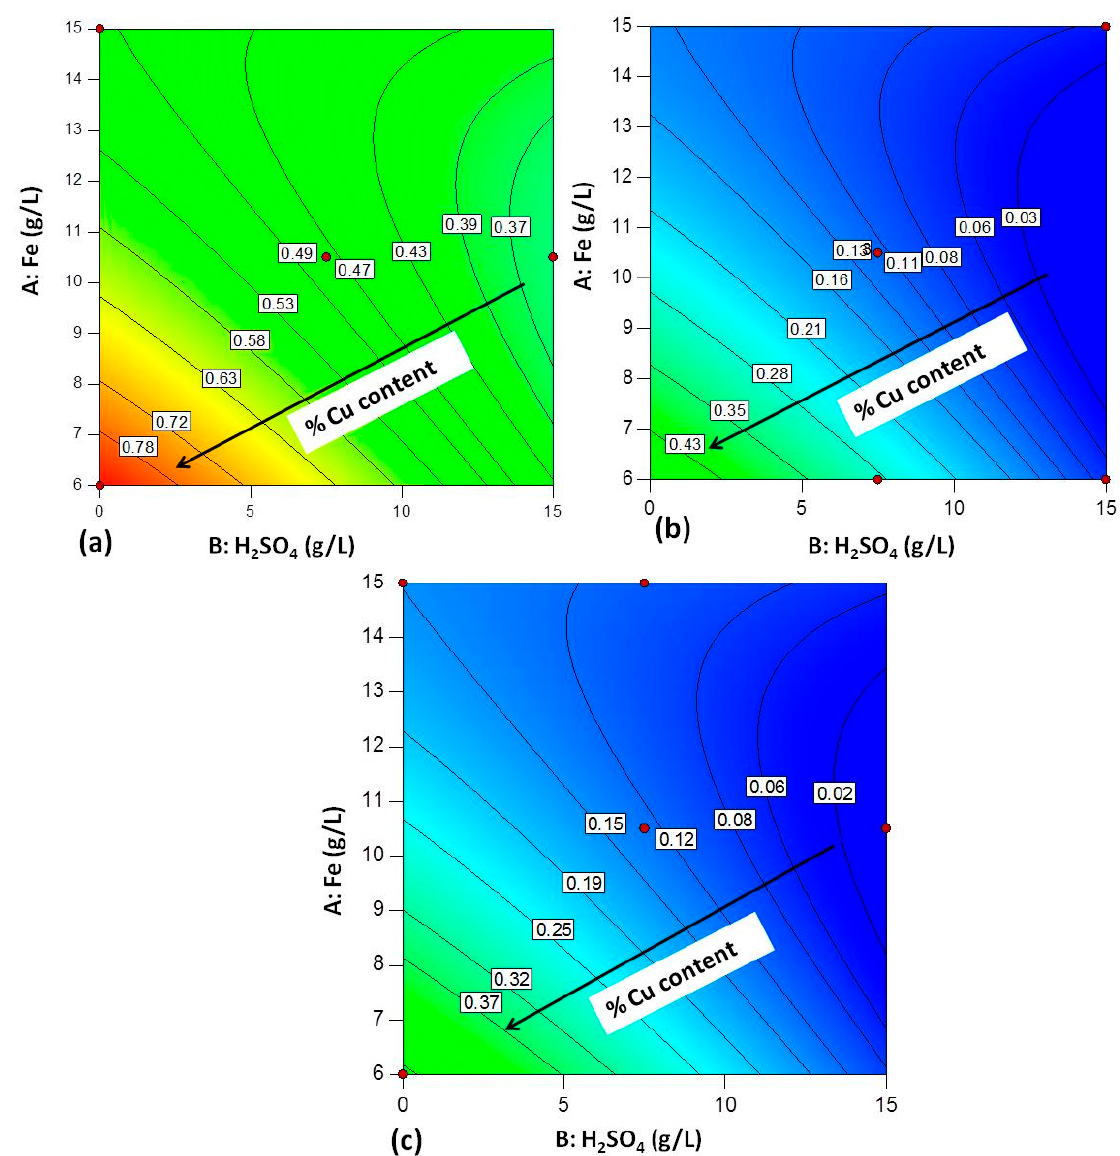
Figure 4. The 2D contour plots for the interaction effects of initial H 2 SO 4 and initial Fe(III) concentrations on %Cu content of precipitates: ( a ) Seed = 0 g/L, ( b ) seed = 7.5 g/L, ( c ) seed = 15 g/L.